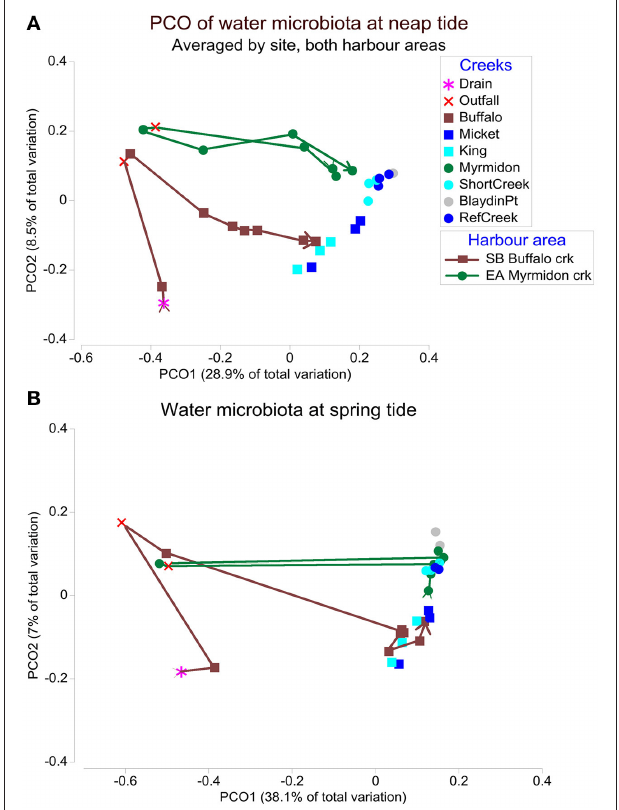
FIGURE 2 | The water microbiota at neap and spring tides. Principal coordinate ordination (PCO) plots of the microbiota for East Arm and Shoal Bay water during (A) neap tides and (B) spring tides. The PCOs are based on a weighted UniFrac distance matrix of microbial OTUs averaged by site. The trajectories indicate Buffalo Creek (brown) and Myrmidon Creek (green) from sites upstream to the mouth. The first two PCO axes explained 37.4% of the microbial variation in (A) and 45.1% in (B)